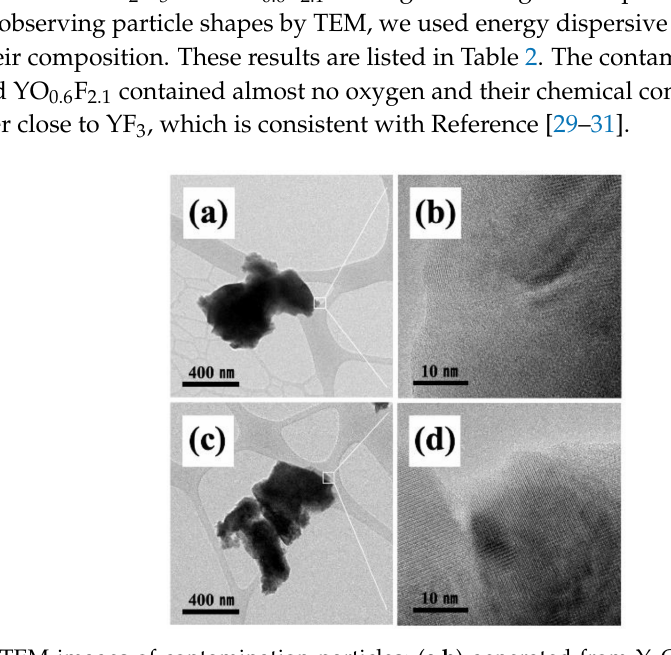
Figure 7. TEM images of contamination particles; ( a , b ) generated from Y 2 O 3 and ( c , d ) generated in YO 0.6 F 2.1